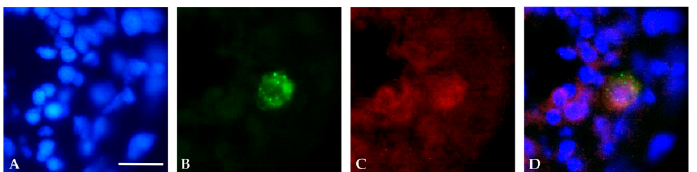
Figure 5. Immunofluorescence analysis of transverse sections of a 24 hpf embryo. ( A ) Nuclei were detected with Hoechst (blue). ( B ) p.R239C expression (GFP-green), ( C ) identified by anti-human GFAP antibody (red). ( D ) Representation of the overlap of the three images. Scale bar ( A – D ): 20 µ m.